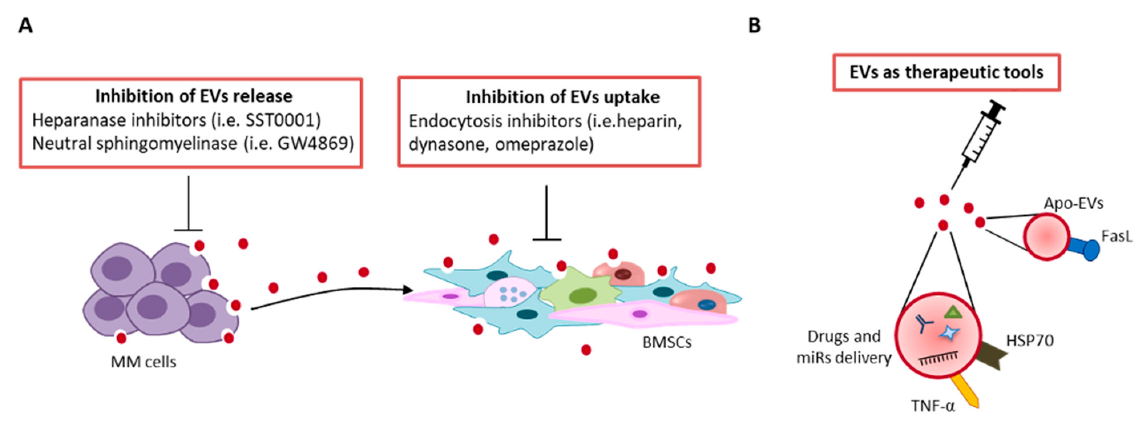
Figure 3. Schematic representation of EV therapeutic perspectives: ( A ) inhibition of EVs release and uptake, ( B ) EVs as therapeutic tools. For more details see the main text.